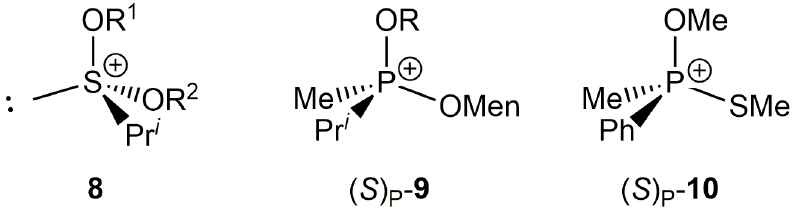
Figure 1. Structures of model compounds used in our studies on identity reactions.